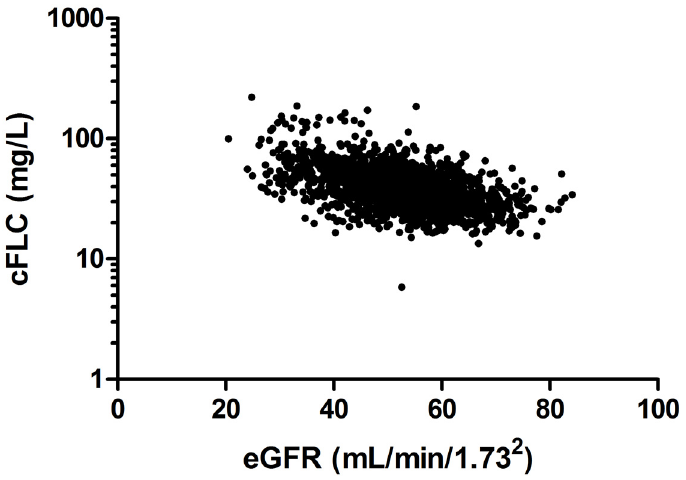
Fig 4. Correlation of cFLC and eGFR. There was a significant inverse association with cFLC (combined serum free light chains) and estimated glomerular filtration rate (eGFR) (rho = -0.49, P < 0.0001). Spearman rank correlation was